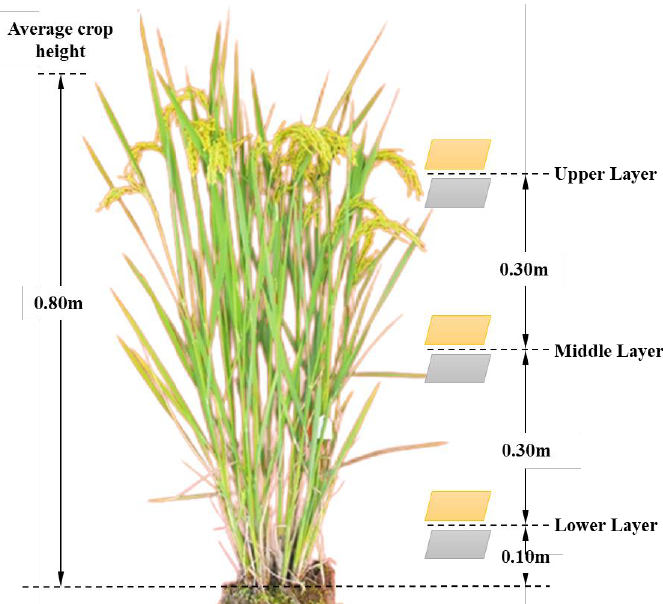
Figure 3. Location of the water-sensitive paper.